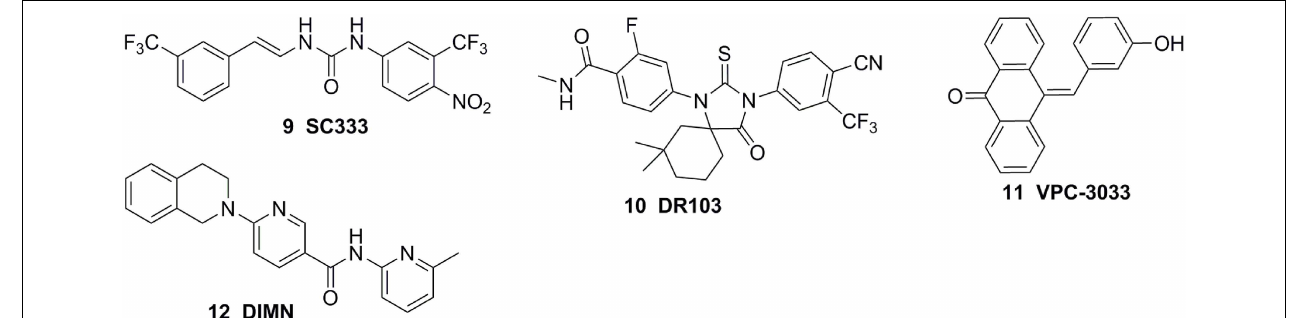
FIGURE 5 | Chemical structures of AR Antagonists based on Structure of